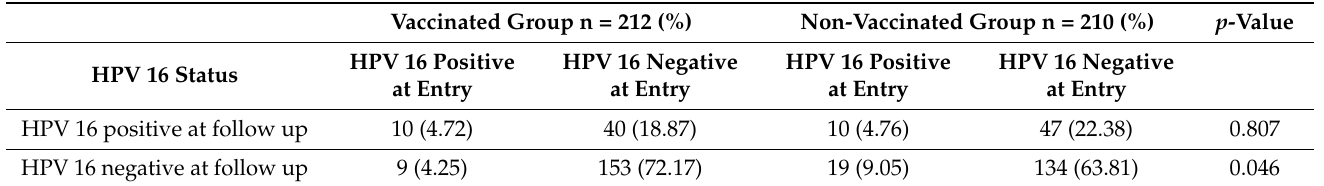
Table 4. HPV 16 status at entry and at follow-up in the study and control groups.